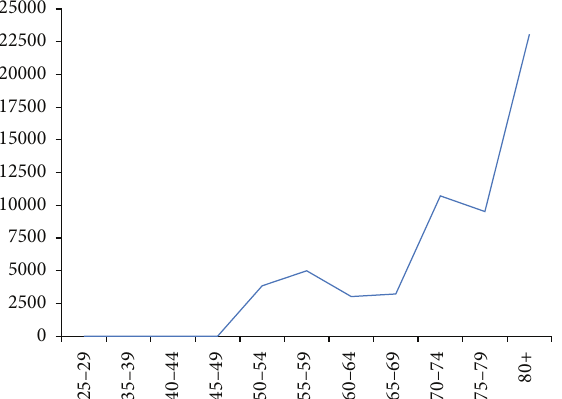
Figure 1: Age-specific mortality rates (per 100,000) in recruited Iranian Parkinson’s disease patients.